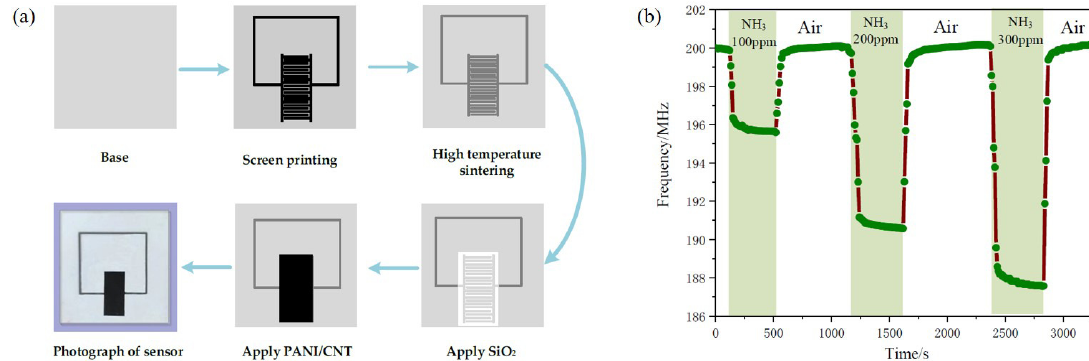
Figure 8. Characterization of the PANi/CNT composite-based ammonia gas sensor. ( a ) Fabrication process of the sensor. ( b ) Response and recovery time curve with different concentrations of ammonia gas